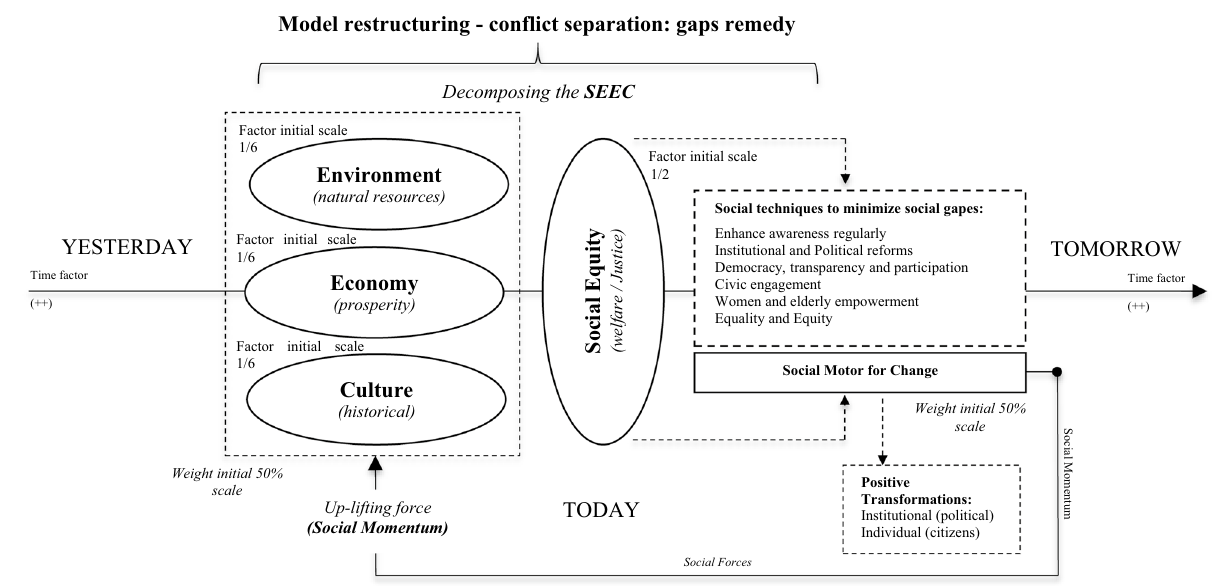
Fig. 5 Model 2: Decomposing the 4DSS, conflict separation model for generating social driving force–short term initiation model